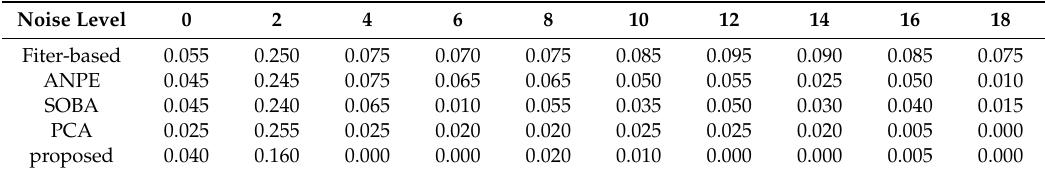
Table 1. The confusion rates of the confusion matrices generated by the classification of noisy image patches into di ff erent noise levels with di ff erent estimation methods.